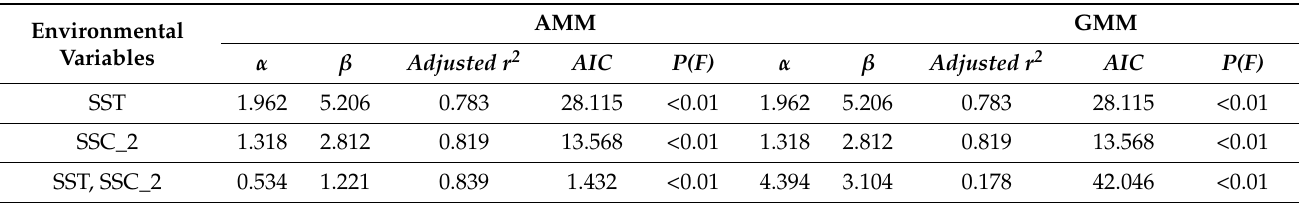
Figure 7. Monthly spatial distribution of SIO albacore standardized CPUE in relation to SSC_2 and SST from April to September (major fishing period). The red line indicates the 17.5 ◦ C SST isotherm in the current month, and the green line represents the 0.08 mg m − 3 SSC_2 isopleth at a time delay of 2 months. Table 3. Comparison between two empirical habitat suitability index models with the selected remote sensing environmental parameters for the SIO albacore